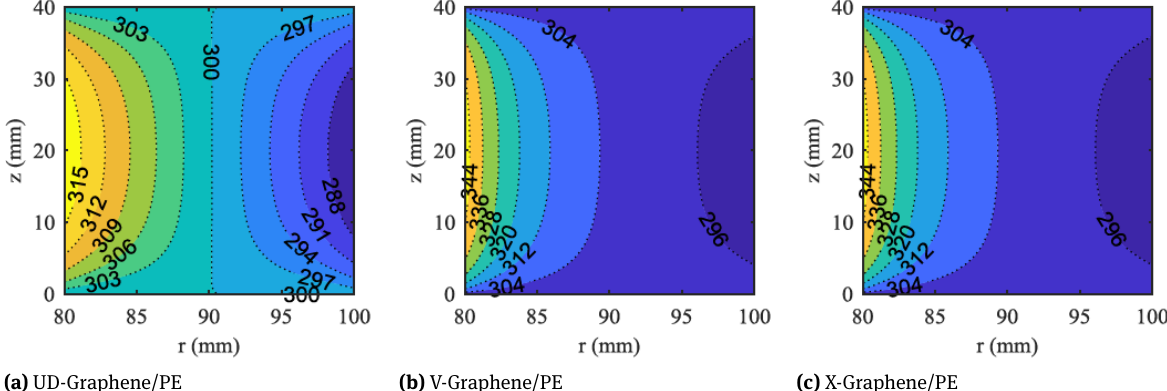
Figure 11: Two-dimensional temperature (K) profiles a) UD, b) V and c) X-graphene/PE cylinders subjected to Q i = 5 kW/ m 2 and Q o = − Q i ( r i / r o ) and T u = T d = 300